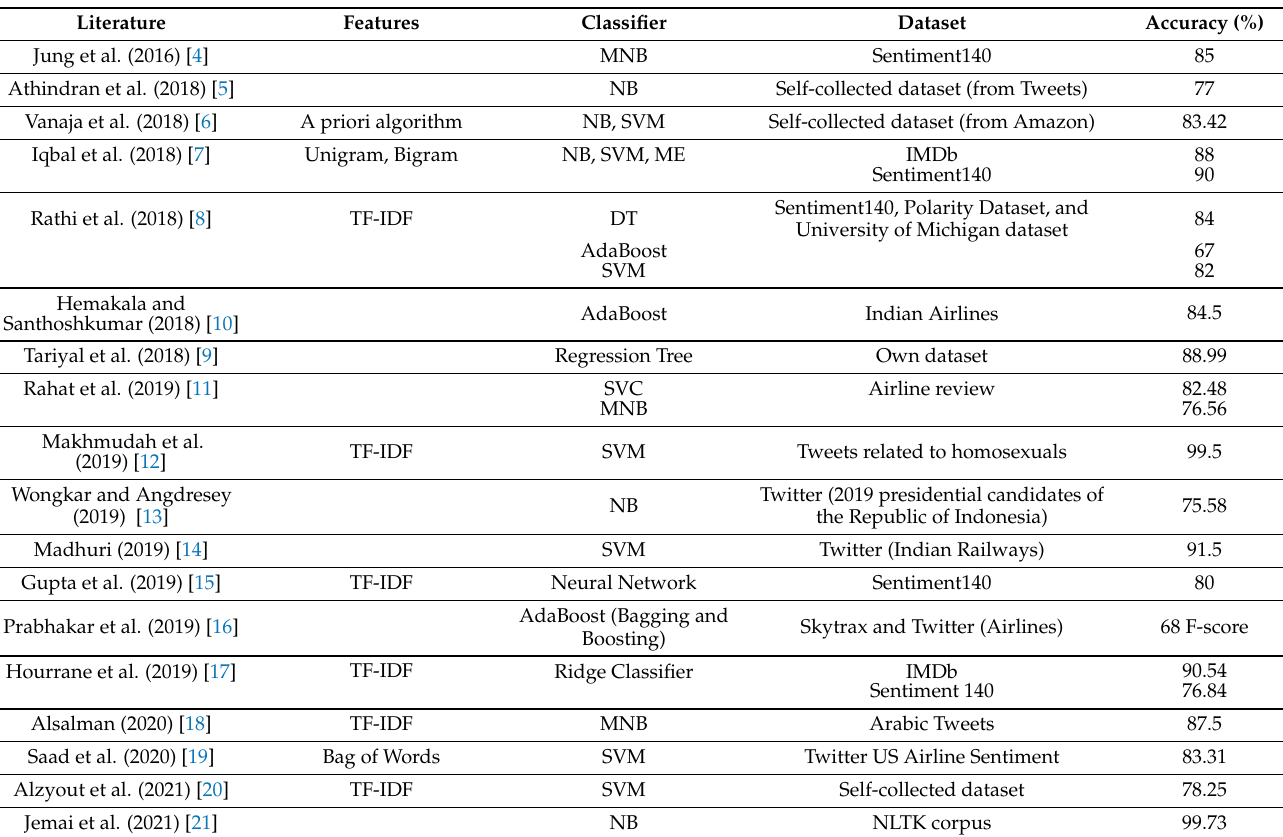
Table 1. Summary of machine learning